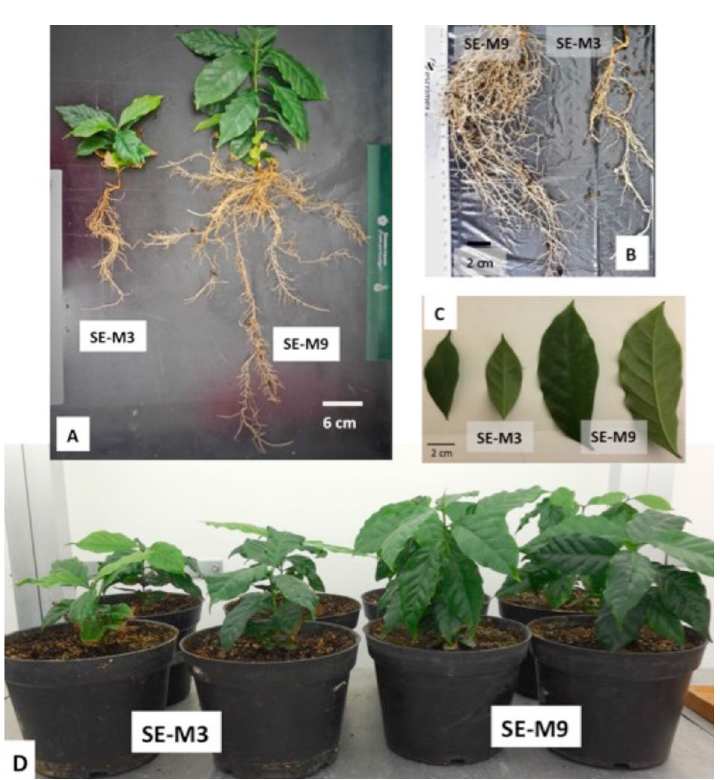
Figure 2. Morphology of plants after eight months in soil conditions under a growth chamber. ( A ) Plants derived from osmotic stress are robustness, with a higher leaf and root area than plants from non-osmotic medium (SE-M3). ( B ) Comparison of root area between SE-M9 and SE-M3 plants. ( C ) Comparison of leaf area between SE-M9 and SE-M3 plants. ( D ) Overview of plants derived from osmotic (SE-M9) and non-osmotic (SE-M3) medium in soil conditions after eight